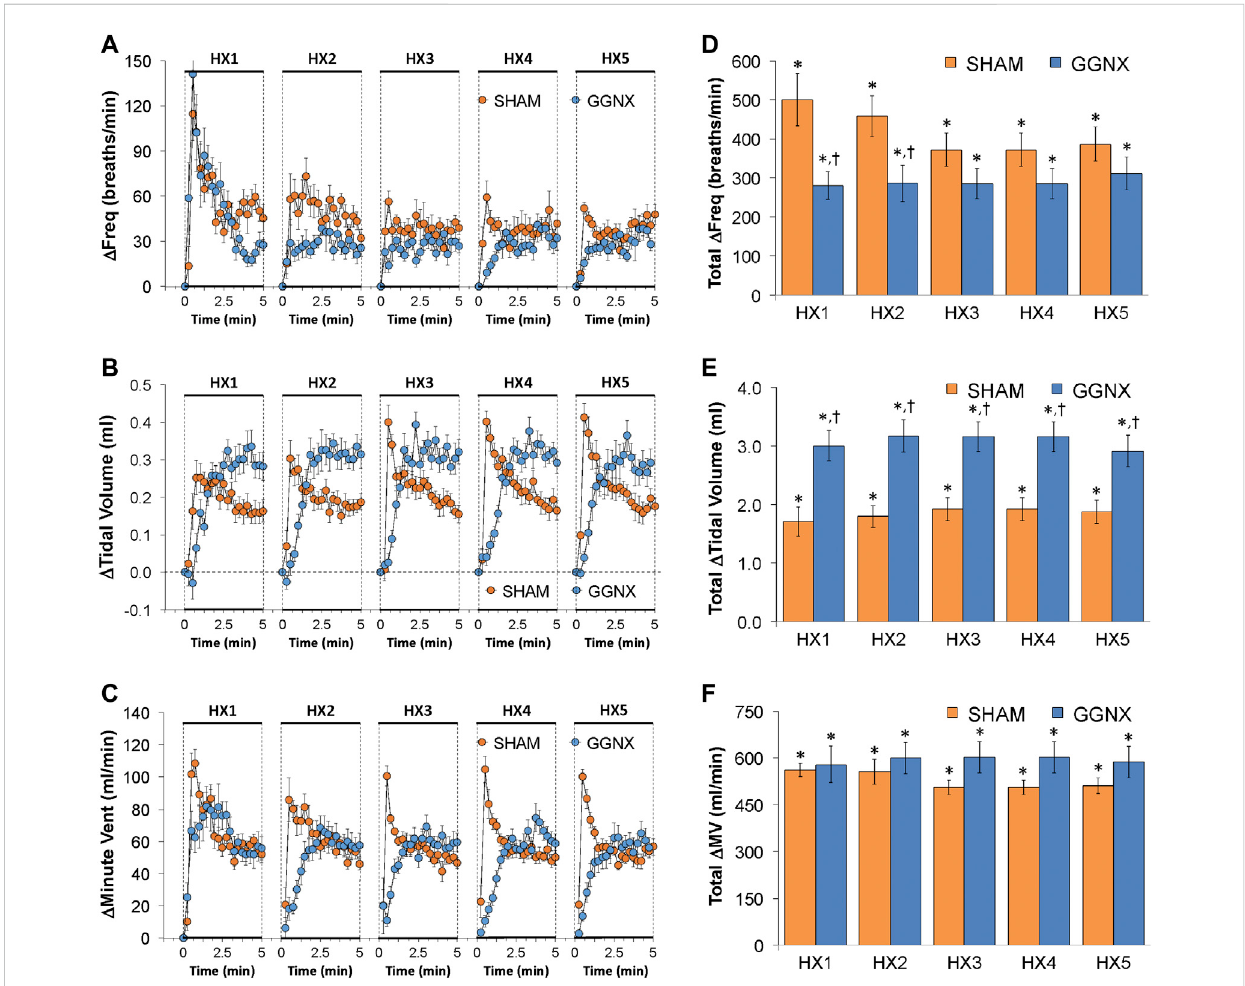
FIGURE 5 Arithmetic changes in the frequency of breathing (A) , tidal volume (B) and minute ventilation (C) in sham-operated (SHAM) rats and in rats with bilateral ganglioglomerular nerve transection (GGNX) during the fi ve hypoxic (HX, 10% O 2 , 90% N 2 ) gas challenges. Total changes in frequency of breathing (D) , tidal volume (E) and minute ventilation (F) during the fi nal 2.5 min of HX gas challenge. The SHAM group had 10 rats. The GGNX group had 12 rats. The data are presented as mean ± SEM. * p < 0.05, signi fi cant response. † p < 0.05, GGNX rats versus SHAM